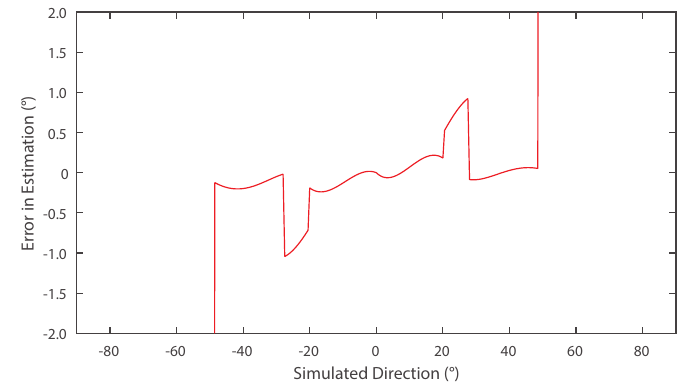
Figure 6. Simulated error in direction of arrival estimation when the best result is picked from a linear array using five or three of its elements.